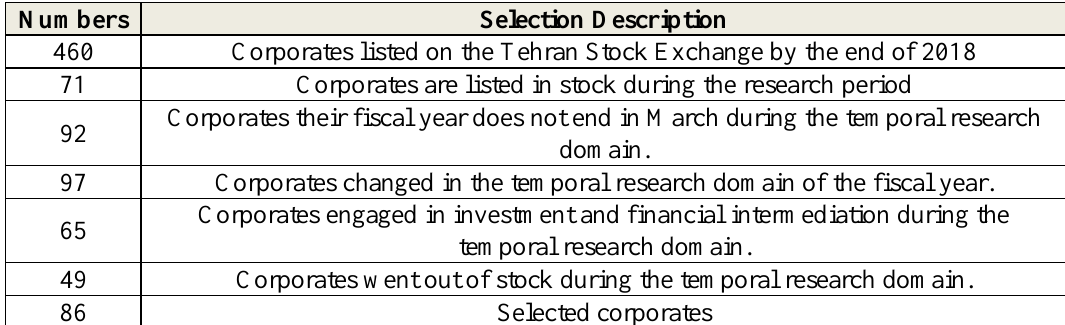
Table 1 : The number of exemplary